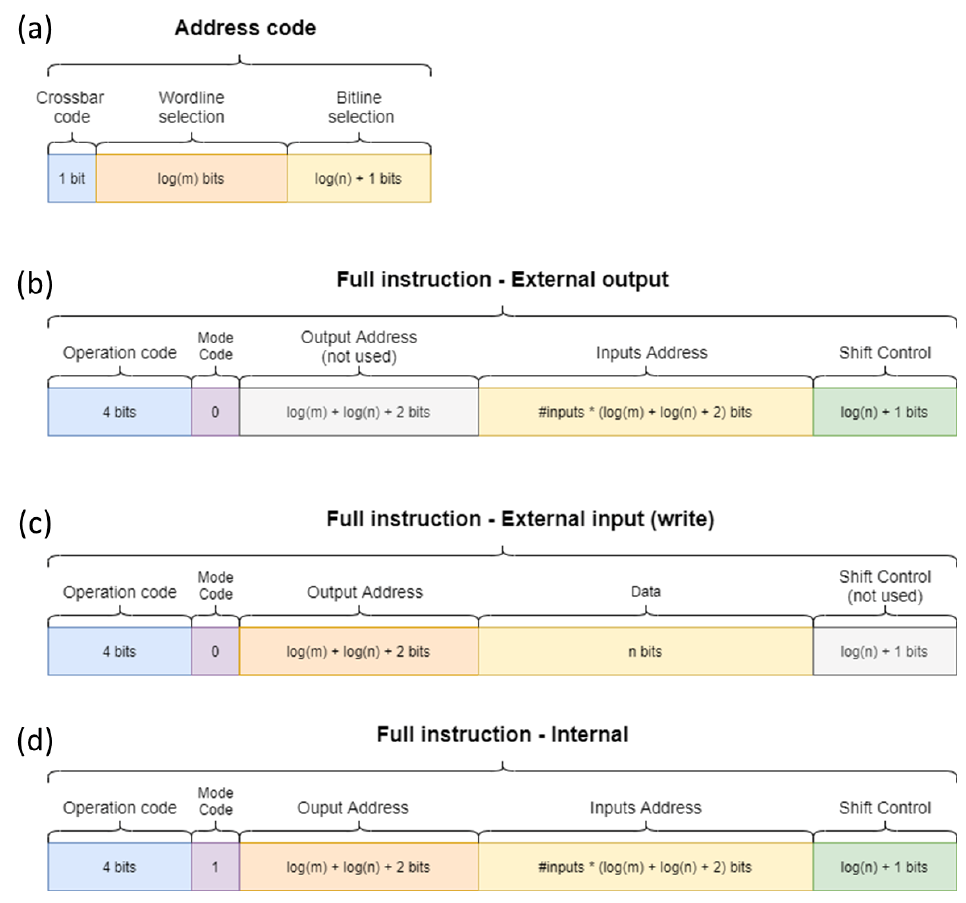
Figure 9. Description of the fields composing the system instructions. ( a ) The form of the address code present in all instruction types. The full instruction form for memory read/logic operations towards the external interface is shown in ( b ), and for memory write operations of externally applied input, it is shown in ( c ). The full instruction form for memory read/logic operations when the output is written to the adjacent sub-array is shown in ( d ). Unused fields are shown in a light gray color.